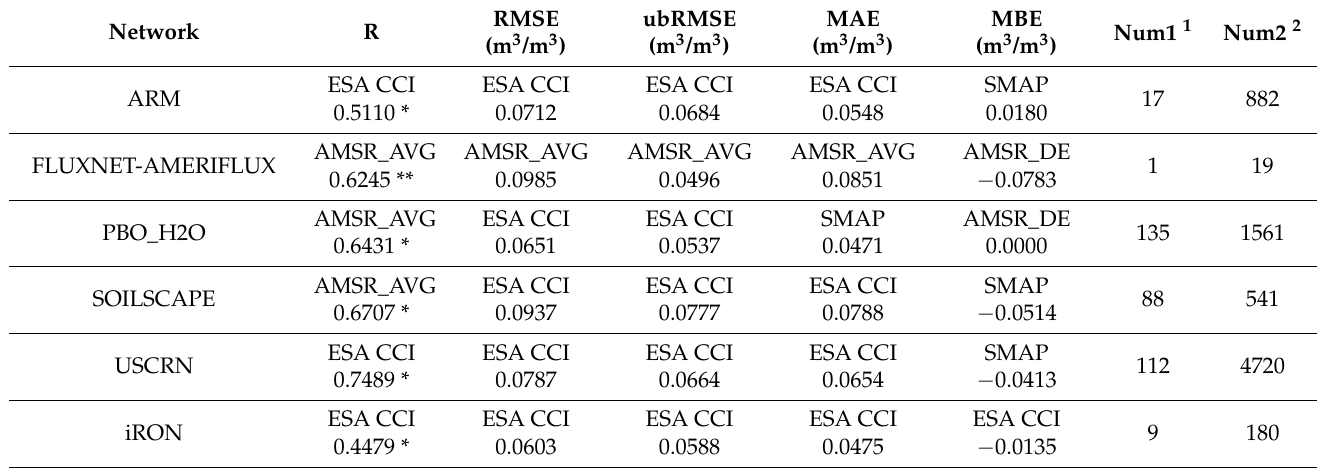
Table 4. Products with the best performance over different observation networks.